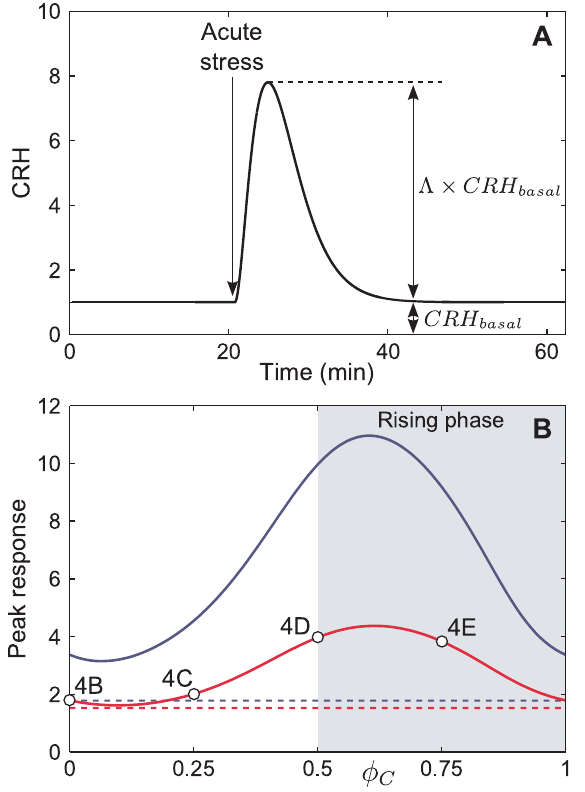
Figure 4. Computational illustrations of timing relationship between a CRH impulse and the magnitude of the CORT response. (A) CRH impulse corresponding to w C ~ 0 for L ~ 6 : 8 . (B–E) Time histories showing of levels of ACTH (blue) and CORT (red) for fixed L ~ 6 : 8 and values of w C as indicated in the panels. Vertical arrow in each panel indicates the timing of the applied CRH impulse. Levels of CORT in the absence of an impulse are shown in grey, with expected peaks indicated by vertical lines. The induced phase shift is the time- separation between expected peaks (vertical lines) in the unperturbed case and the actual peak in CORT (black points) for the perturbed case.